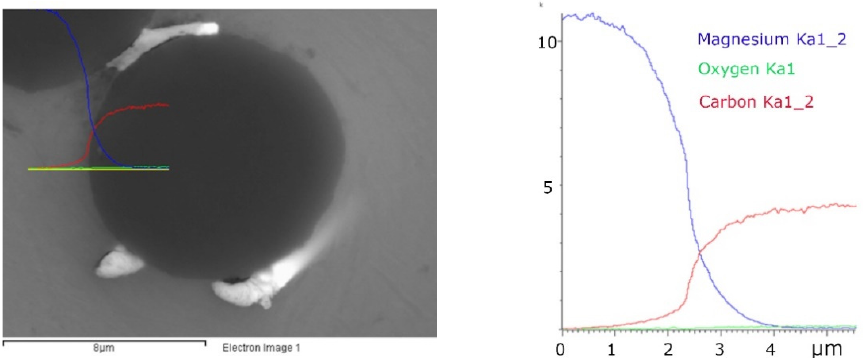
Figure 7. A line scan analysis of the fiber/matrix interface of the Mg1.8Y/Granoc composite without the reaction product. Analyzed interfacial area ( left ) and the signal intensity diagram of analyzed interfacial area ( right ). Colored lines are related to analyzed elements C (red), O (green), Mg (blue), signal intensity is measured in kilocounts per second (kcps) plotted on the y-axis.